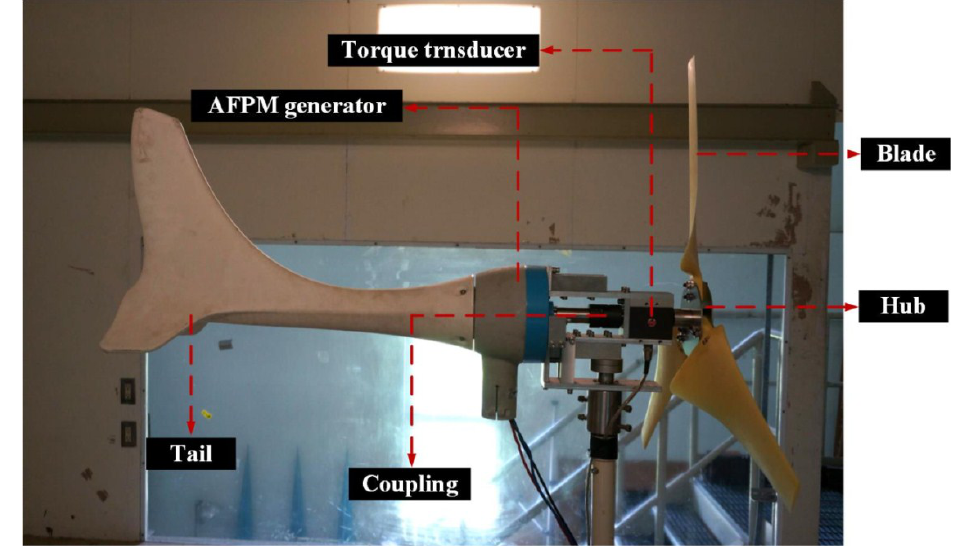
Figure 12. The wind turbine system setup in the full-scale wind